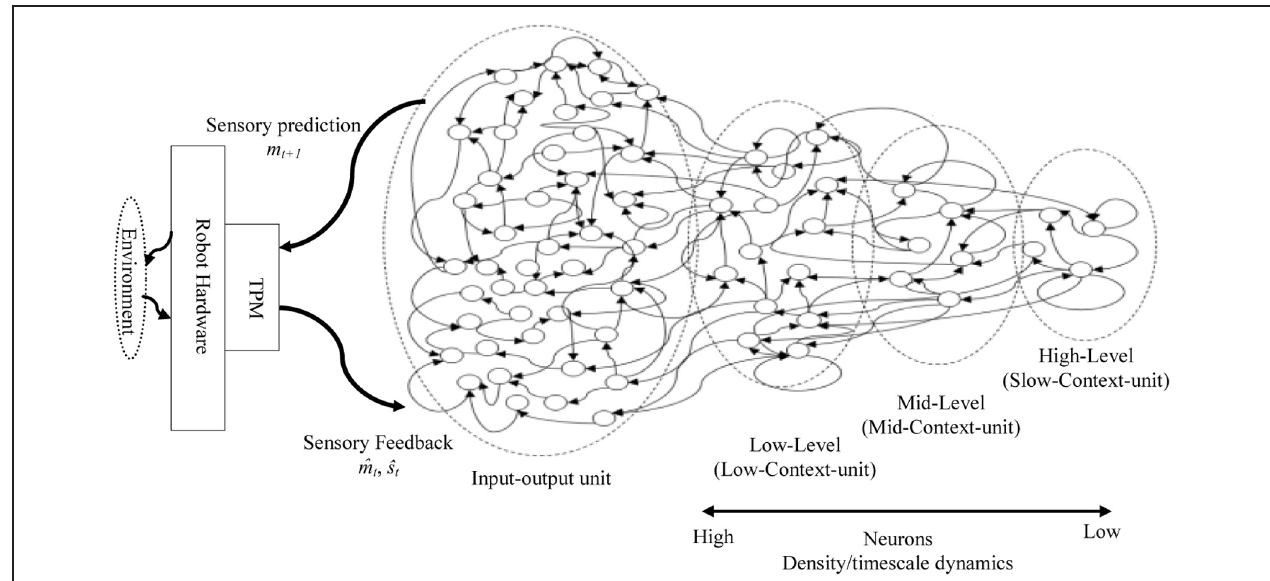
FIGURE 2 | A sample of the proposed MTRNN model. The basic layout of the model inspired by Figure 1 . In the model, neurons in the slow context unit have lower number and slower timescale dynamics than the